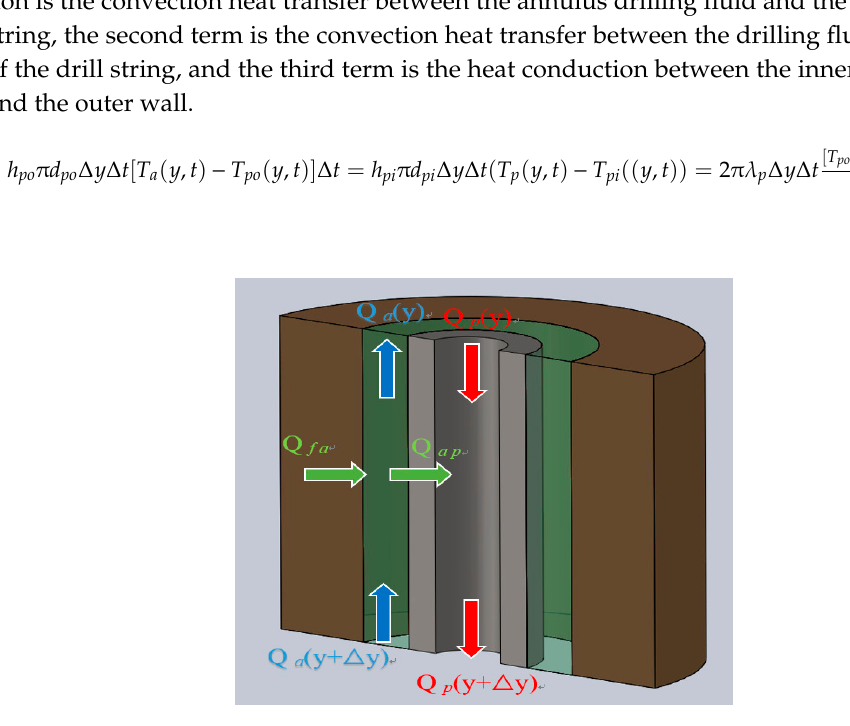
Figure 2. Heat transfer physical model in control element.